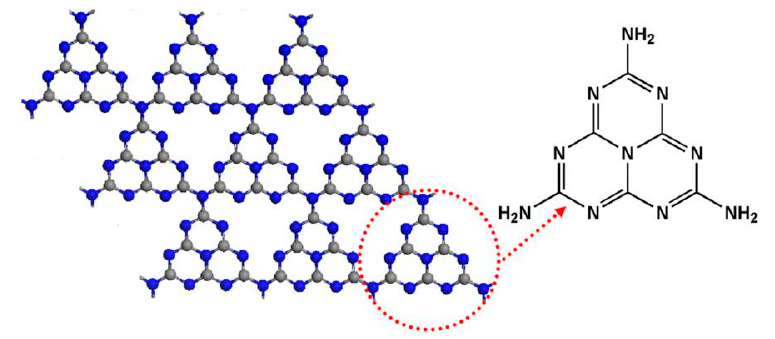
Figure 6. Schematic display of the structure of g-C 3 N 4 . Reproduced with permission from Reference [72]; copyright (2014), American Chemical Society.